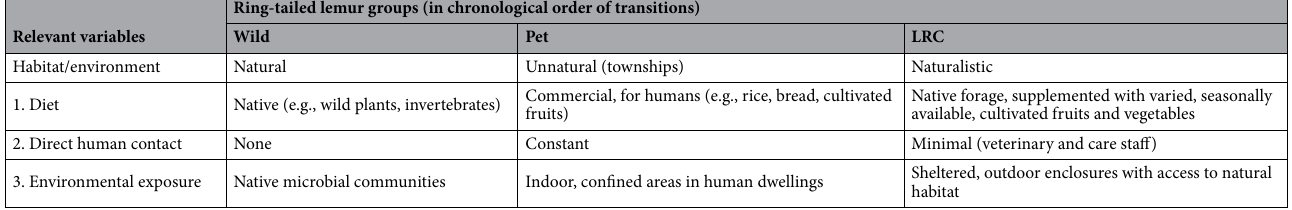
Table 1. The study subjects, their habitats, and three factors influencing their gut